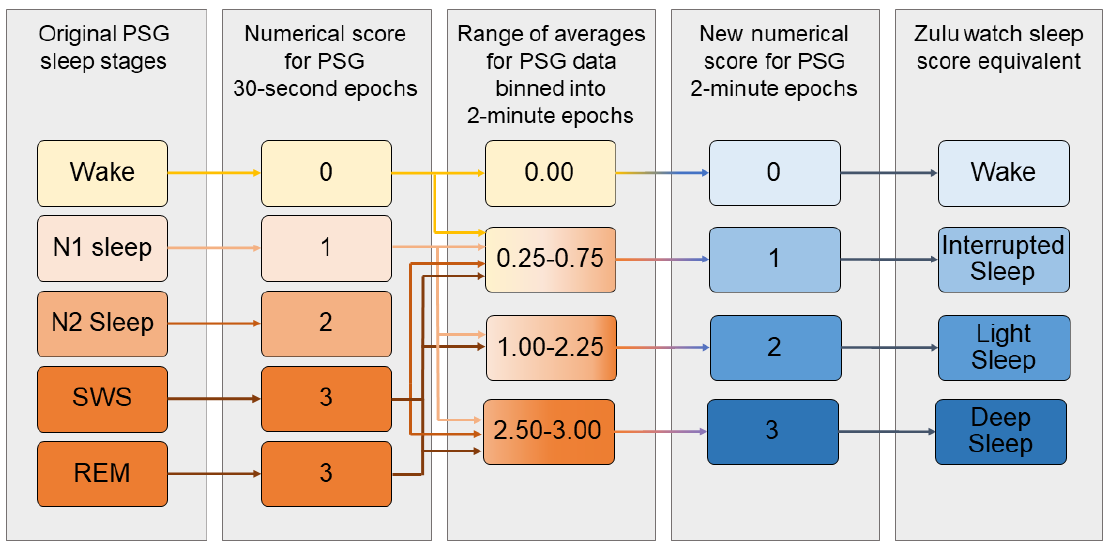
Figure 1. Recoding the polysomnography (PSG) sleep stages from 30-s epochs into 2-min Zulu watch sleep score equivalents. REM, rapid eye movement; SWS, slow-wave sleep.